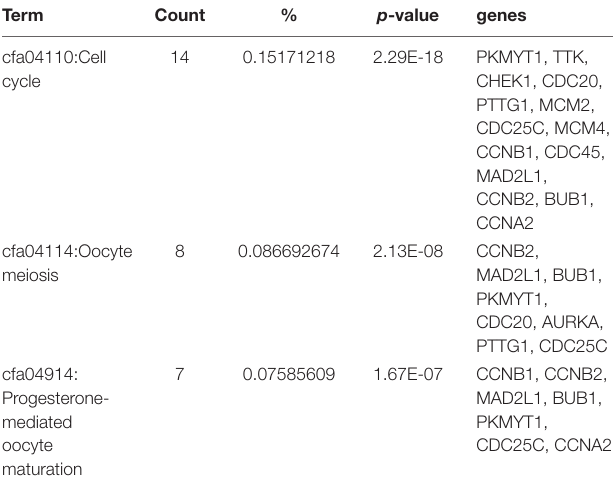
Eraser (Takara), and SYBR Premix Ex TaqII (Takara) was used TABLE 4 | KEGG pathway enrichment analysis of 53